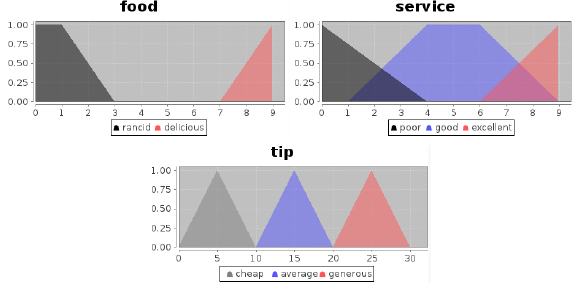
Fig. 2. Membership functions for tipper example. FUNCTION BLOCK tipper VAR